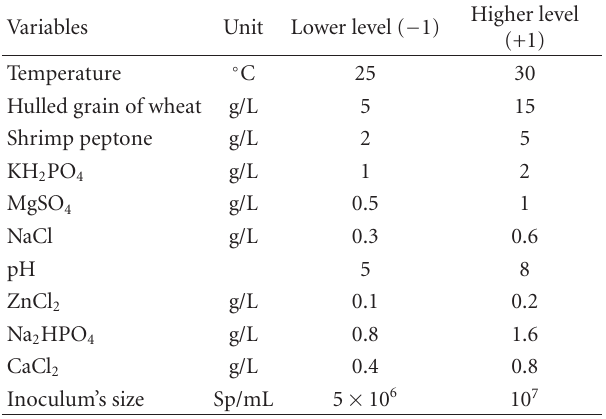
Table 1: Levels of the factors tested for the production of proteases by A. niger I1 using Plackett-Burman